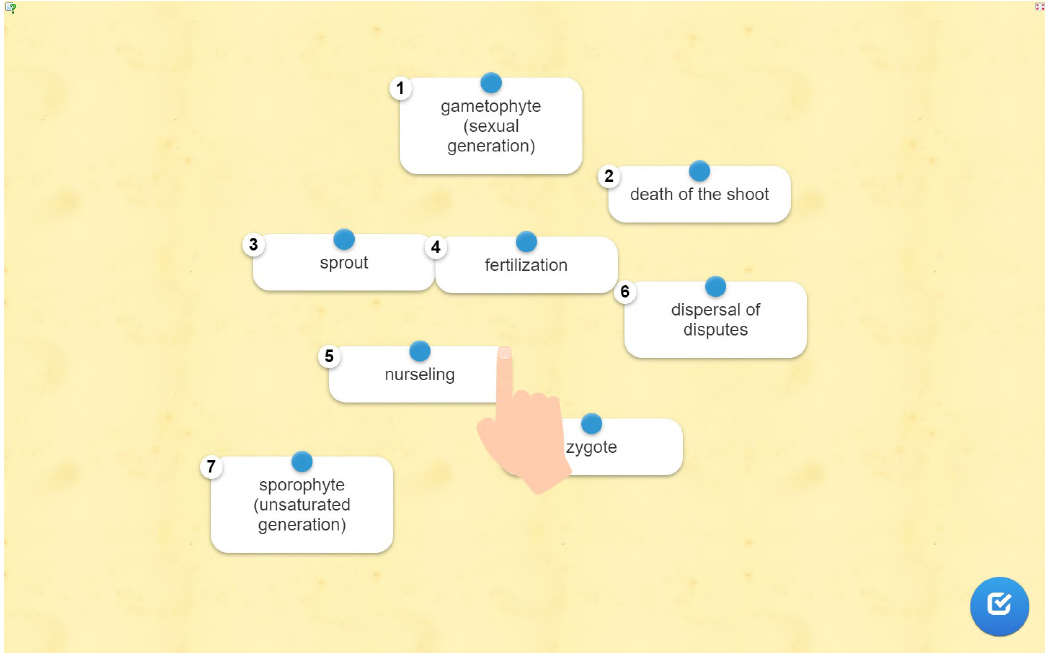
Figure 40: Presentation of paper